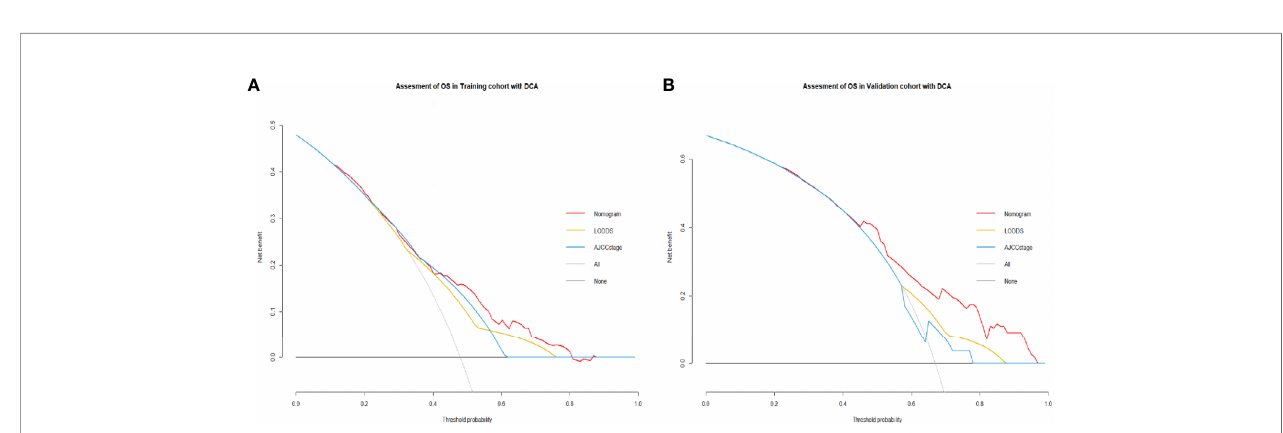
FIGURE 3 | (A) Decision curves showed clinical bene fi ts of the nomogram predicting OS in the training cohort. (B) Decision curves showed clinical bene fi ts of the nomogram predicting OS in the validation